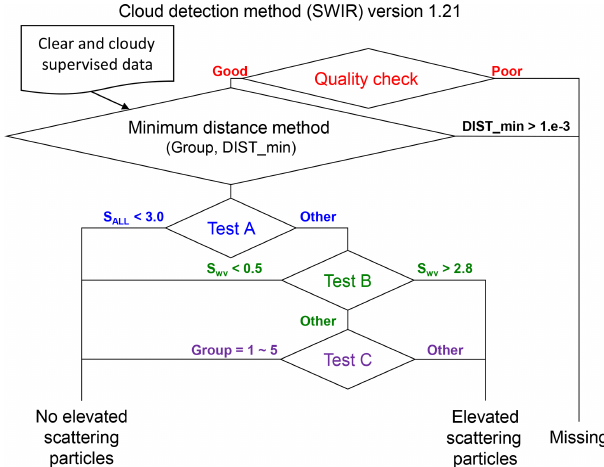
Figure 4. Flowchart of the method for detecting and classifying ele- vated scattering particles from SWIR spectra (Ver. 1.21). The terms in the flowchart are described in Table